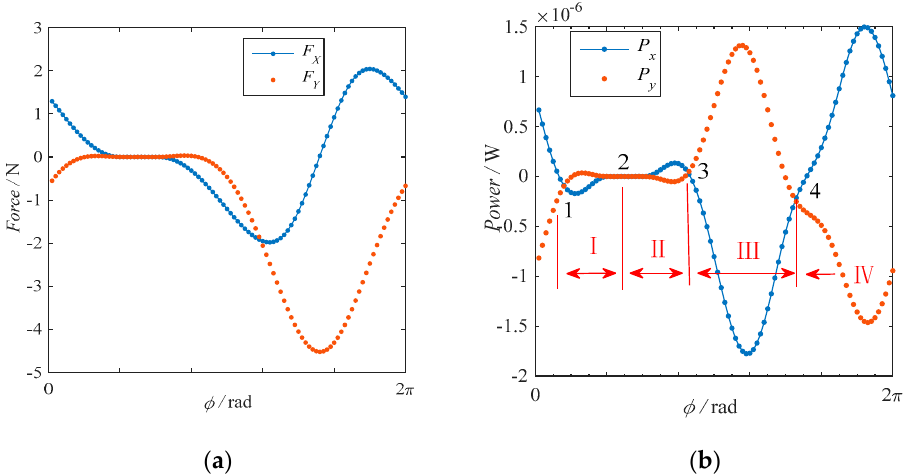
Figure 9. The additional stiffness excitation curves: ( a ) additional stiffness excitation forces, ( b ) the instantaneous power of the excitation forces.